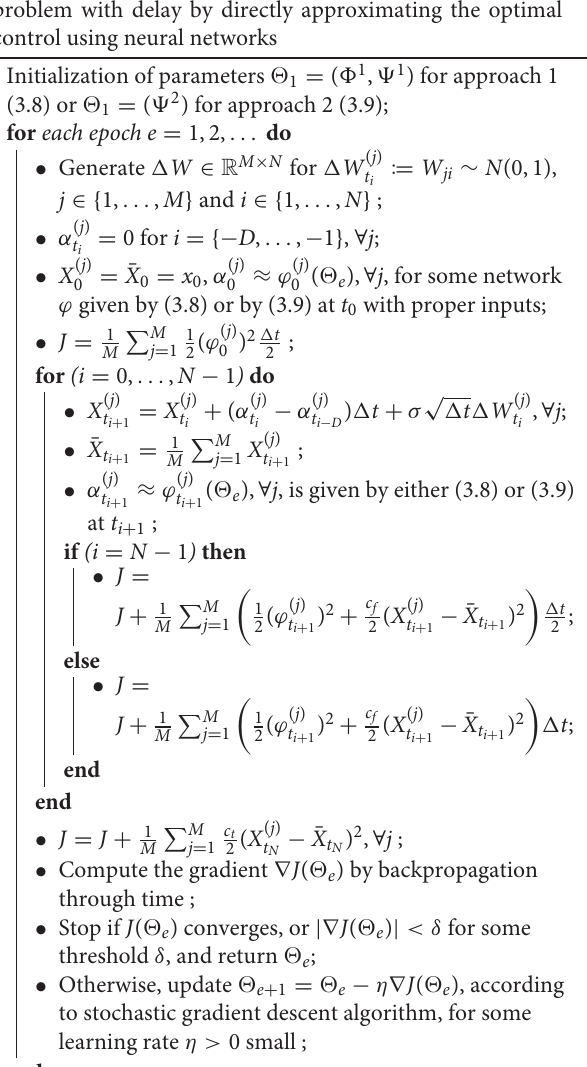
Algorithm 1: Algorithms for solving mean field